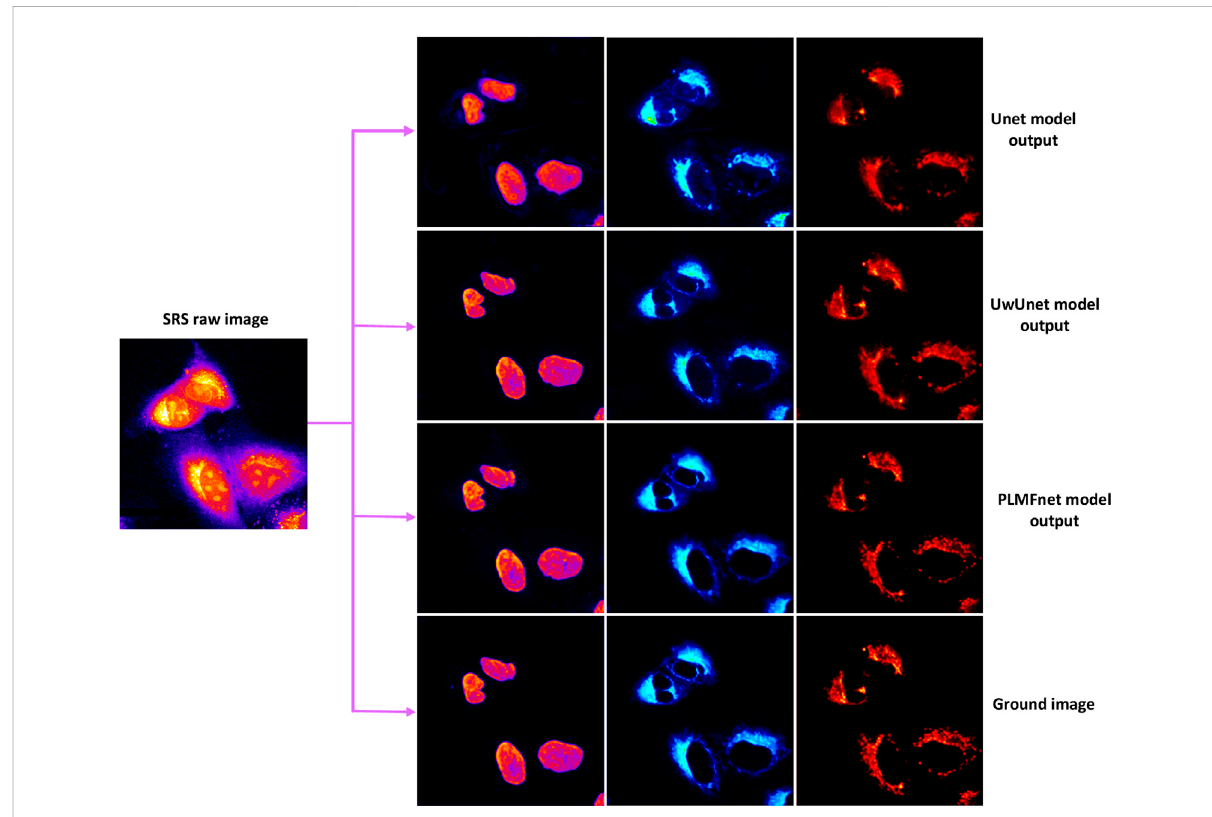
FIGURE 12 Subcellular localization prediction results of differentiation model from the label-free cell image experiments. The results for different organelles ’ locations include nuclei (second column), mitochondria (third column), and endoplasmic reticulum (right) from the single raw SRS- imaging cell